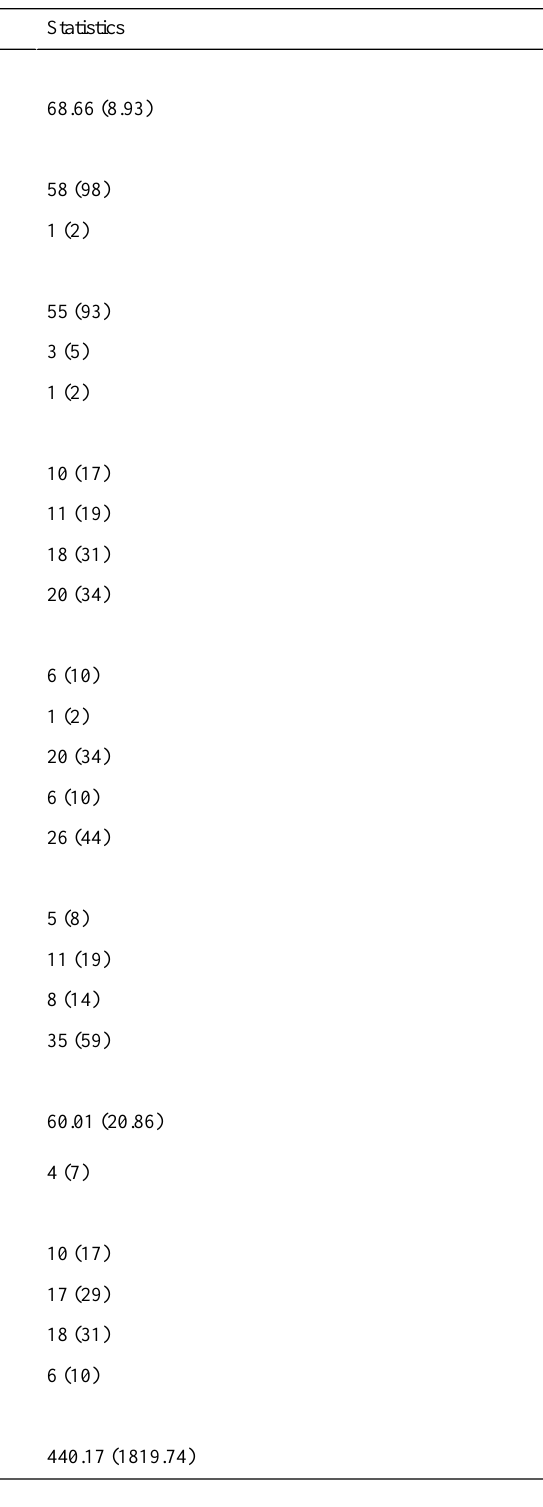
Table 1. Characteristics of study participants